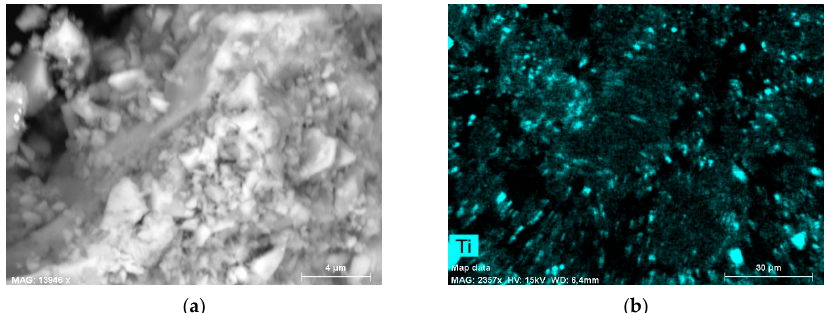
Figure 3. SEM image of the sample surface ( a ) morphology and ( b ) EDS maps of titanium in the investigated region.